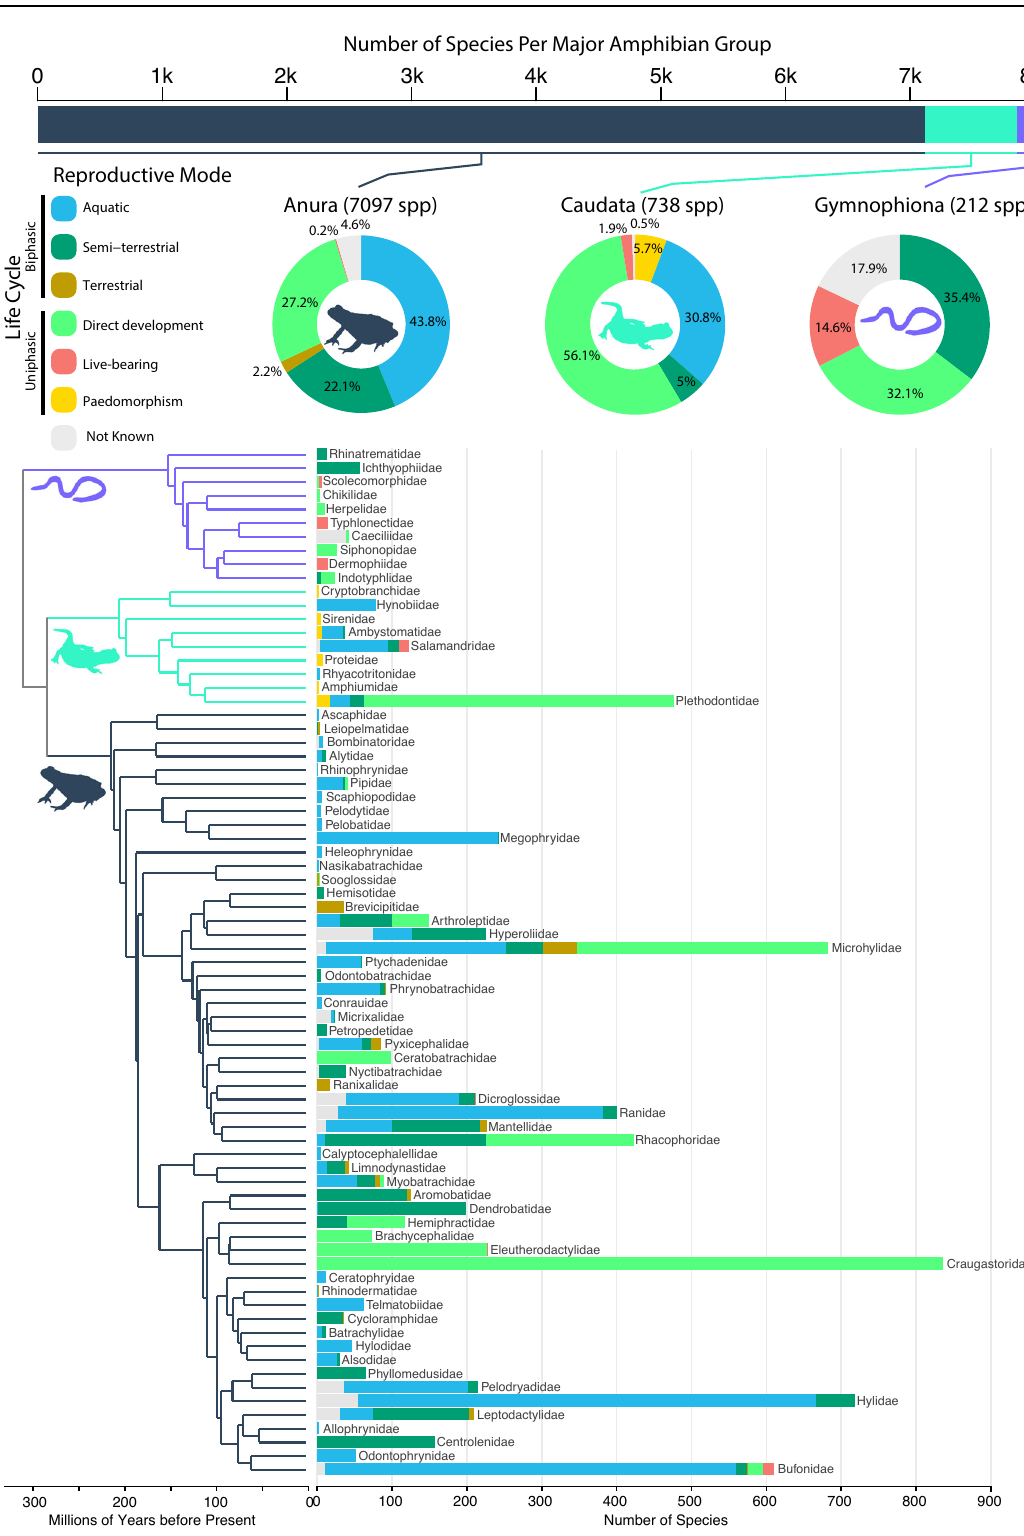
Fig.1|Phylogeneticdistributionofreproductivemodesinamphibians. Species richnessperamphibiangroup(topbarchartwhereAnura:darkbluegray,Caudata: mint green, Gymnophiona: lilac, and 1k=1000 species) and frequencies of repro- ductive modes per group (percentages as pie charts), and per family (numbers of species as stacked bars on phylogeny). Reproductive modes are represented as blue=aquatic;darkgreen=semi-terrestrial;brown=terrestrial;lightgreen=direct